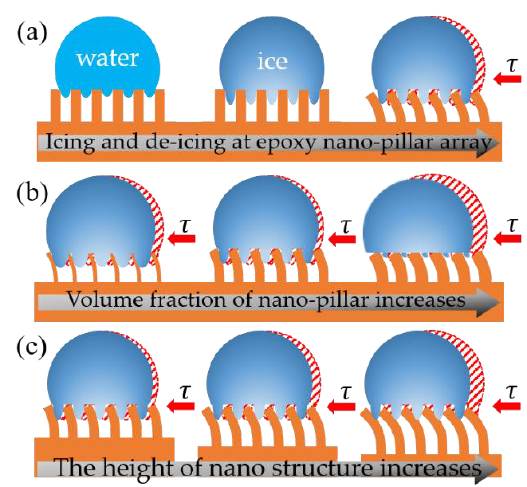
Figure 9. Illustrations of the ice adhesion mechanism of the hydrophobic nano-structure array on fluoridated epoxy (1 wt %): ( a ) The icing and de-icing process on the nano-pillar array EP surface; ( b ) the ice adhesion behavior under different structure volume fractions of nano-pillar arrays; ( c ) the ice adhesion strength under different heights of nano-pillar arrays.